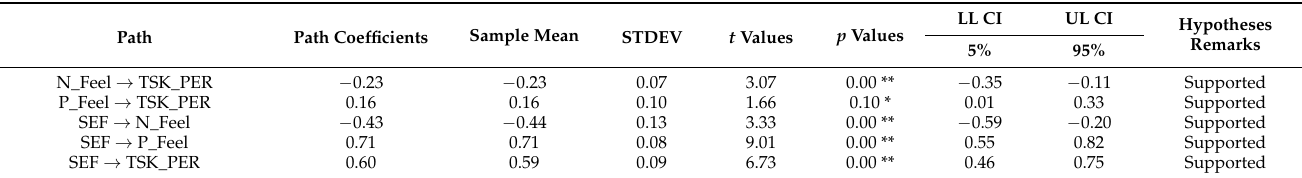
Table 10. Path coefficient and hypothesis